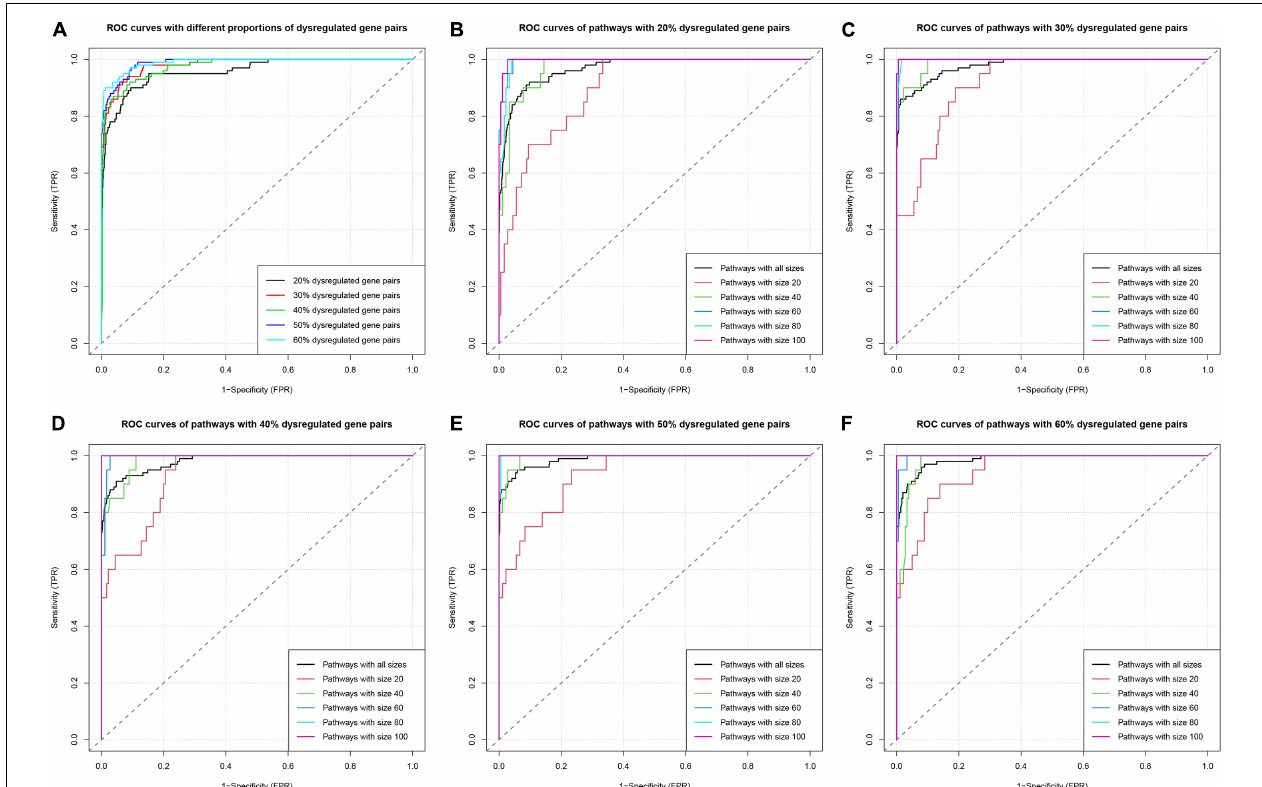
FIGURE 3 | ROC curves in simulation study. ( A ) ROC curves in the five simulations with different proportions (20–60%) of dysregulated gene pairs. ( B ) ROC curves of pathways with different sizes (20, 40, 60, 80, and 100) when the proportion of dysregulated gene pairs is 20%. The group “Pathways with all sizes” means the union set of pathways with different sizes (20, 40, 60, 80, and 100). ( C–F ) Similar to (B) , ROC curves of pathways when the proportions of dysregulated gene pairs are 30–60%,